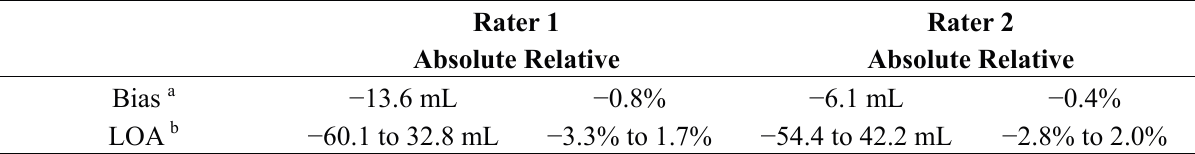
Table 5. Accuracy of SkanLab in measuring human arms (N = 30).